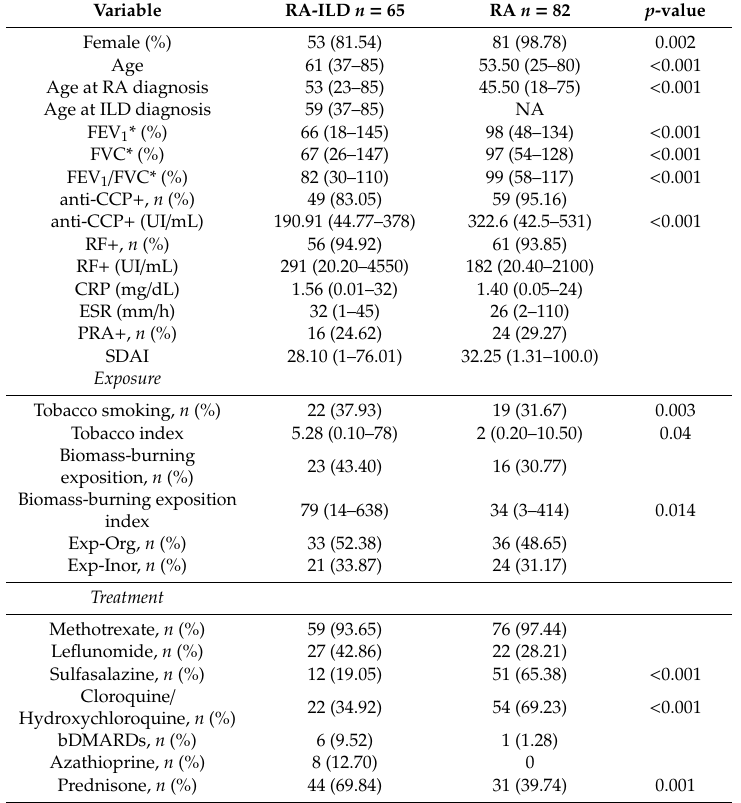
Table 1. Demographics and clinical characteristics of the included